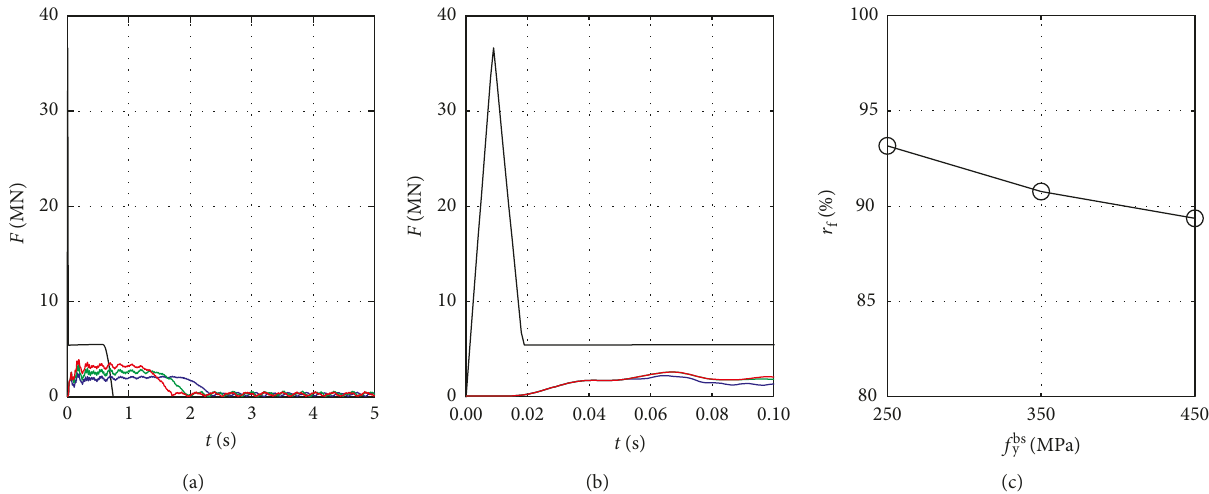
Figure 13: Impact force time histories on the bridge pier for the whole impact process (a), for the first 0.10s of impact process (b) corresponding to different yielding strengths of beam steel and the reduction ratio of maximum impact force versus yielding strength of beam steel f bs (c). y